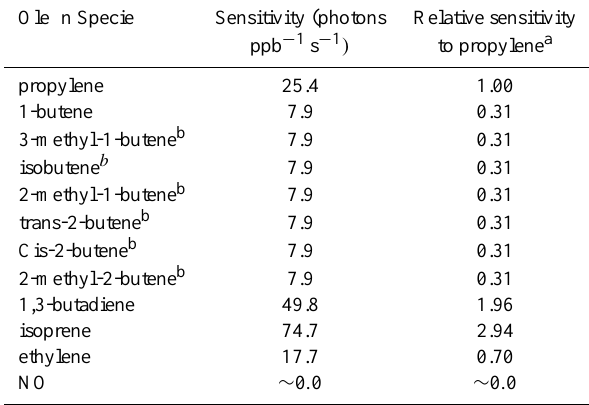
Table 2. Sensitivities and relative sensitivities to propylene for the